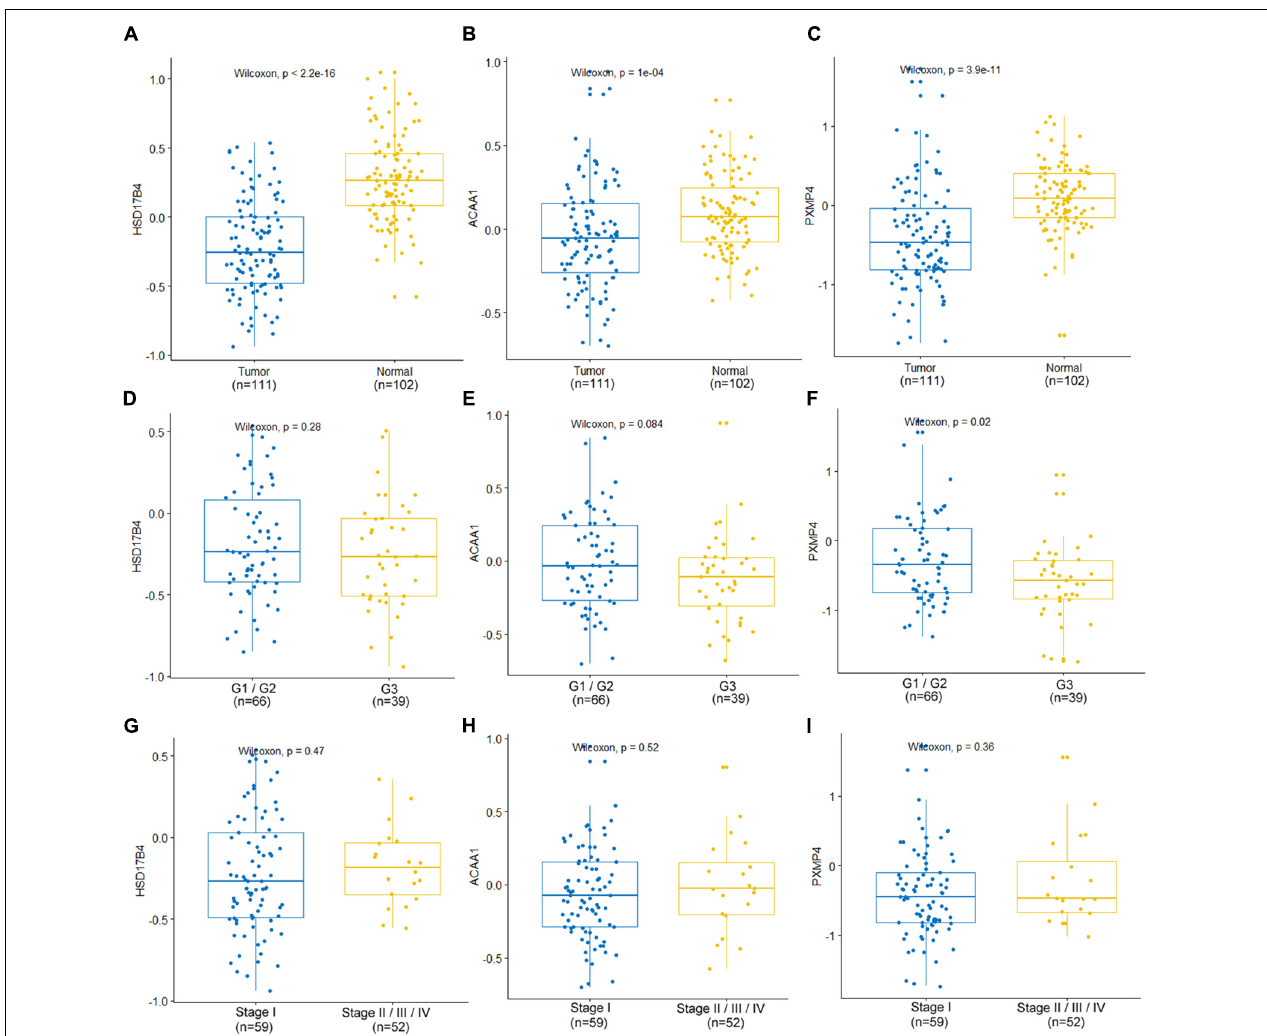
FIGURE 6 | Expression profiles of HSD17B4, ACAA1, and PXMP4 in CPTAC lung cancer dataset. (A–C) Lower expression of HSD17B4, ACAA1 and PXMP4 in the tumors than the normal controls, respectively. (D–F) Expressional comparisons of HSD17B4, ACAA1 and PXMP4 between tumors with well-moderate differentiation (Grade 1 or Grade 2) and those with poor differentiation (Grade 3), respectively. (G–I) Expressional comparisons of HSD17B4, ACAA1, and PXMP4 between tumors of early stage (Stage I) and the late stage ones (Stage II or Stage III or Stage IV), respectively. The y -axis represented the protein abundance of the samples, with respect to the pooled reference sample, as log 2 ratios. The x -axis represented different groups. CPTAC, Clinical Proteomic Tumor Analysis Consortium. Wilcoxon test was used and p < 0.05 was considered